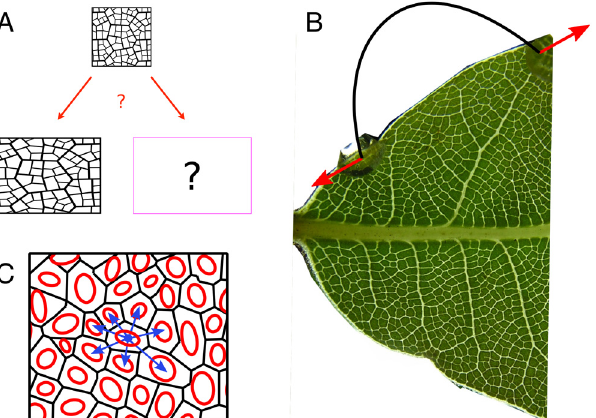
Fig 1. Patterns on a growing tissue: Affine or non-affine behavior? (A) A square-shaped tissue grows anisotropically into a rectangle. Is the pattern passively stretched like a drawing on piece of rubber, or does the pattern geometry influence growth distribution? (B) Typical experiment. A leaf is stretched by applying external forces using a U-shaped steel wire (drawn schematically in black, forces in red). Note the difference in the venation patterns between the stretched and non-stretched sides. (C) Using the texture tensor to quantify vasculature. A part of the vascular network of a leaf, after digitization. Black lines represent veins; the texture tensor of an areole is represented by an ellipse (red) computed from all the vectors connecting its center to the center of neighboring areoles (blue); every ellipse is a representation of the local geometry of the